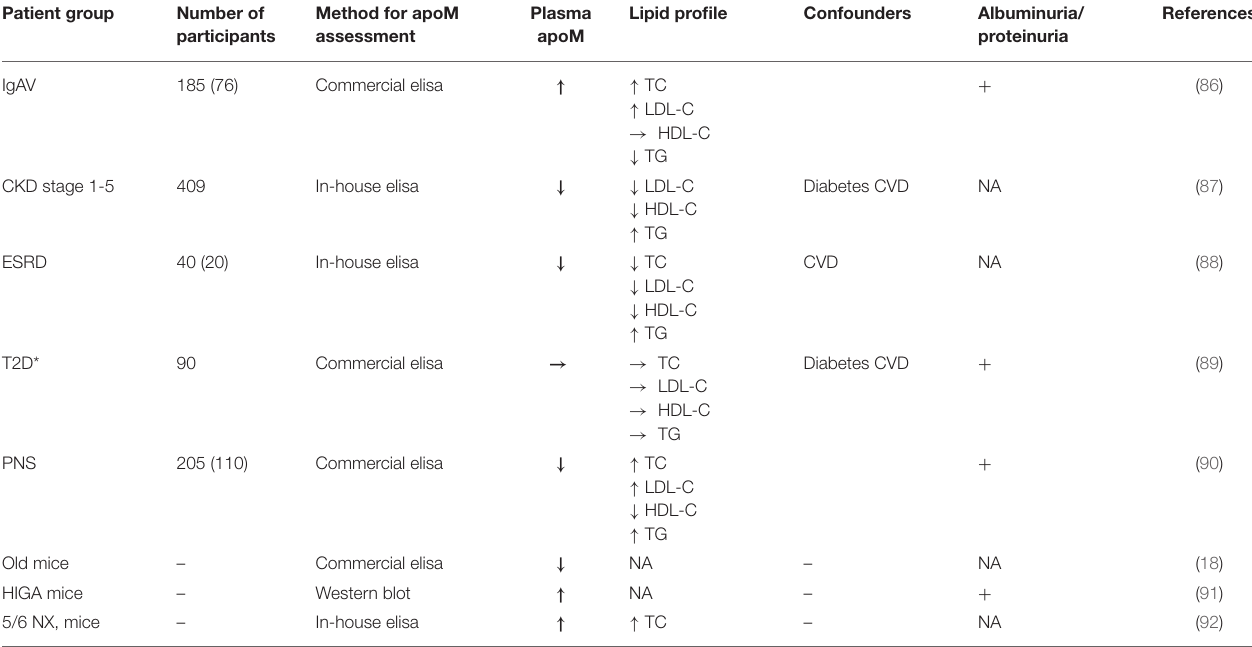
TABLE 1 | Studies of patients or animals with kidney disease and effects on apoM levels. Patient